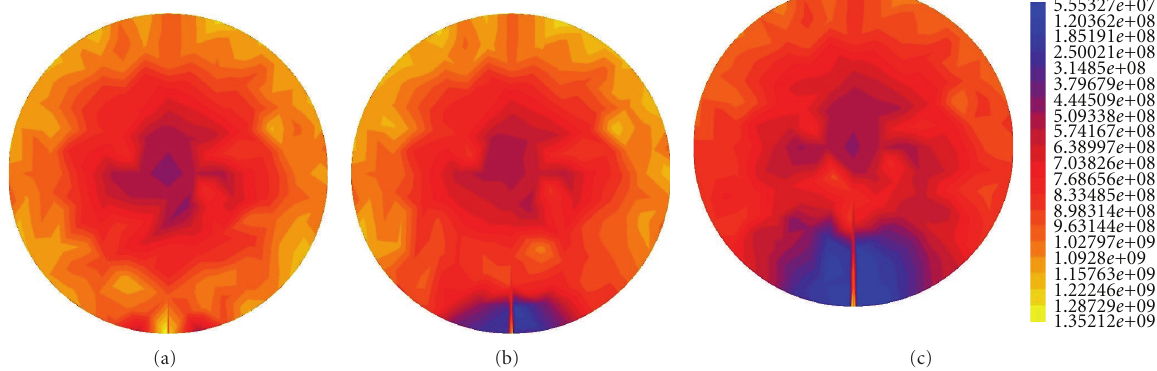
Figure 13: Top view of the von Mises equivalent stress for three cracked pellets type with di ff erent values of